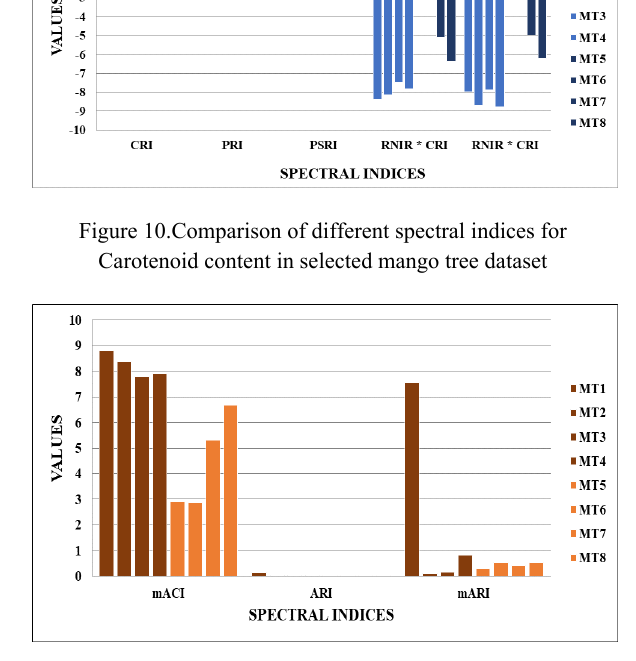
Figure 11.Comparison of different spectral indices for anthocyanin content in selected mango tree